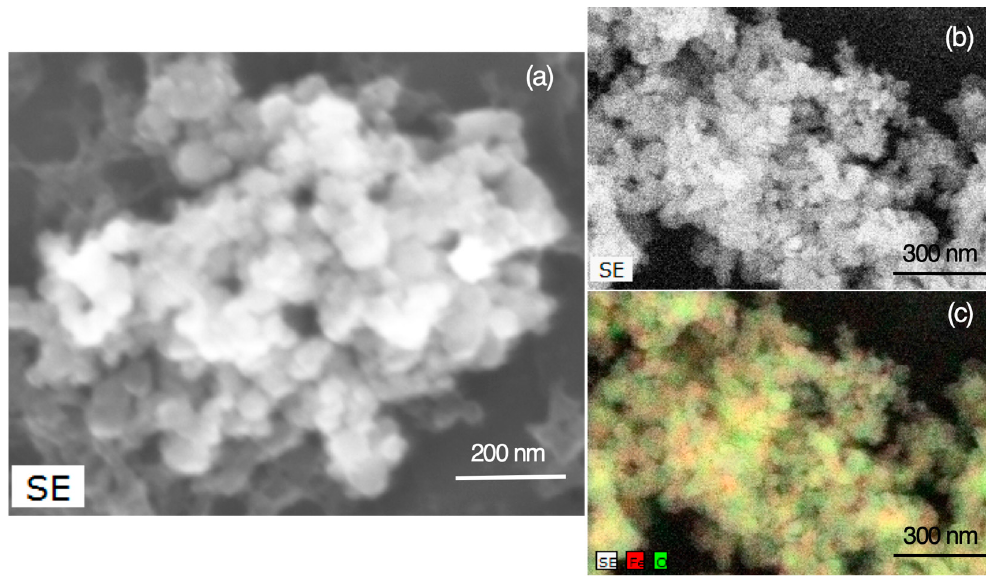
Figure 2. SEM image obtained by secondary electrons at ( a ) 130, ( b ) 80 kx, and ( c ) EDS mapping of Fe 3 O 4 NPs obtained by Cnicus benedictus .